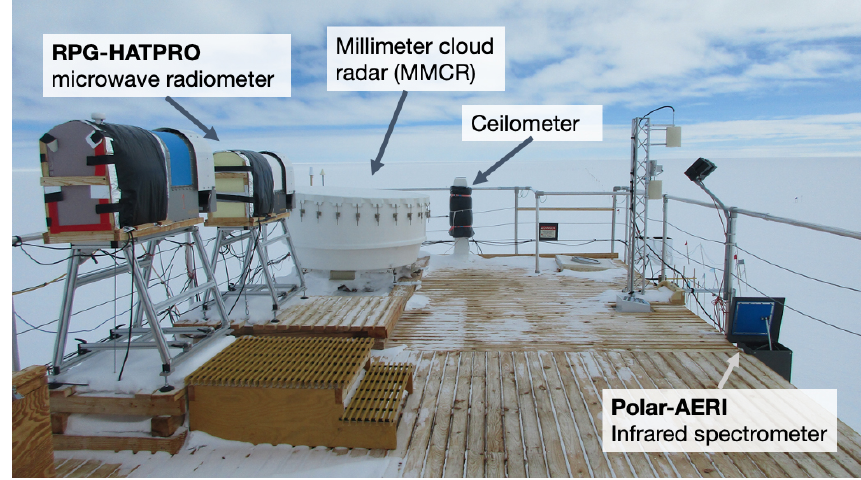
Figure 1. Key ICECAPS-ACE instrumentation at Summit Station (photographed by the author, 16 May 2019). Table 1. Overview of instrumentation used in this study. All instruments were installed at Summit as part of the ICECAPS project (Shupe et al., 2013) or ICECAPS-ACE project (Guy et al.,